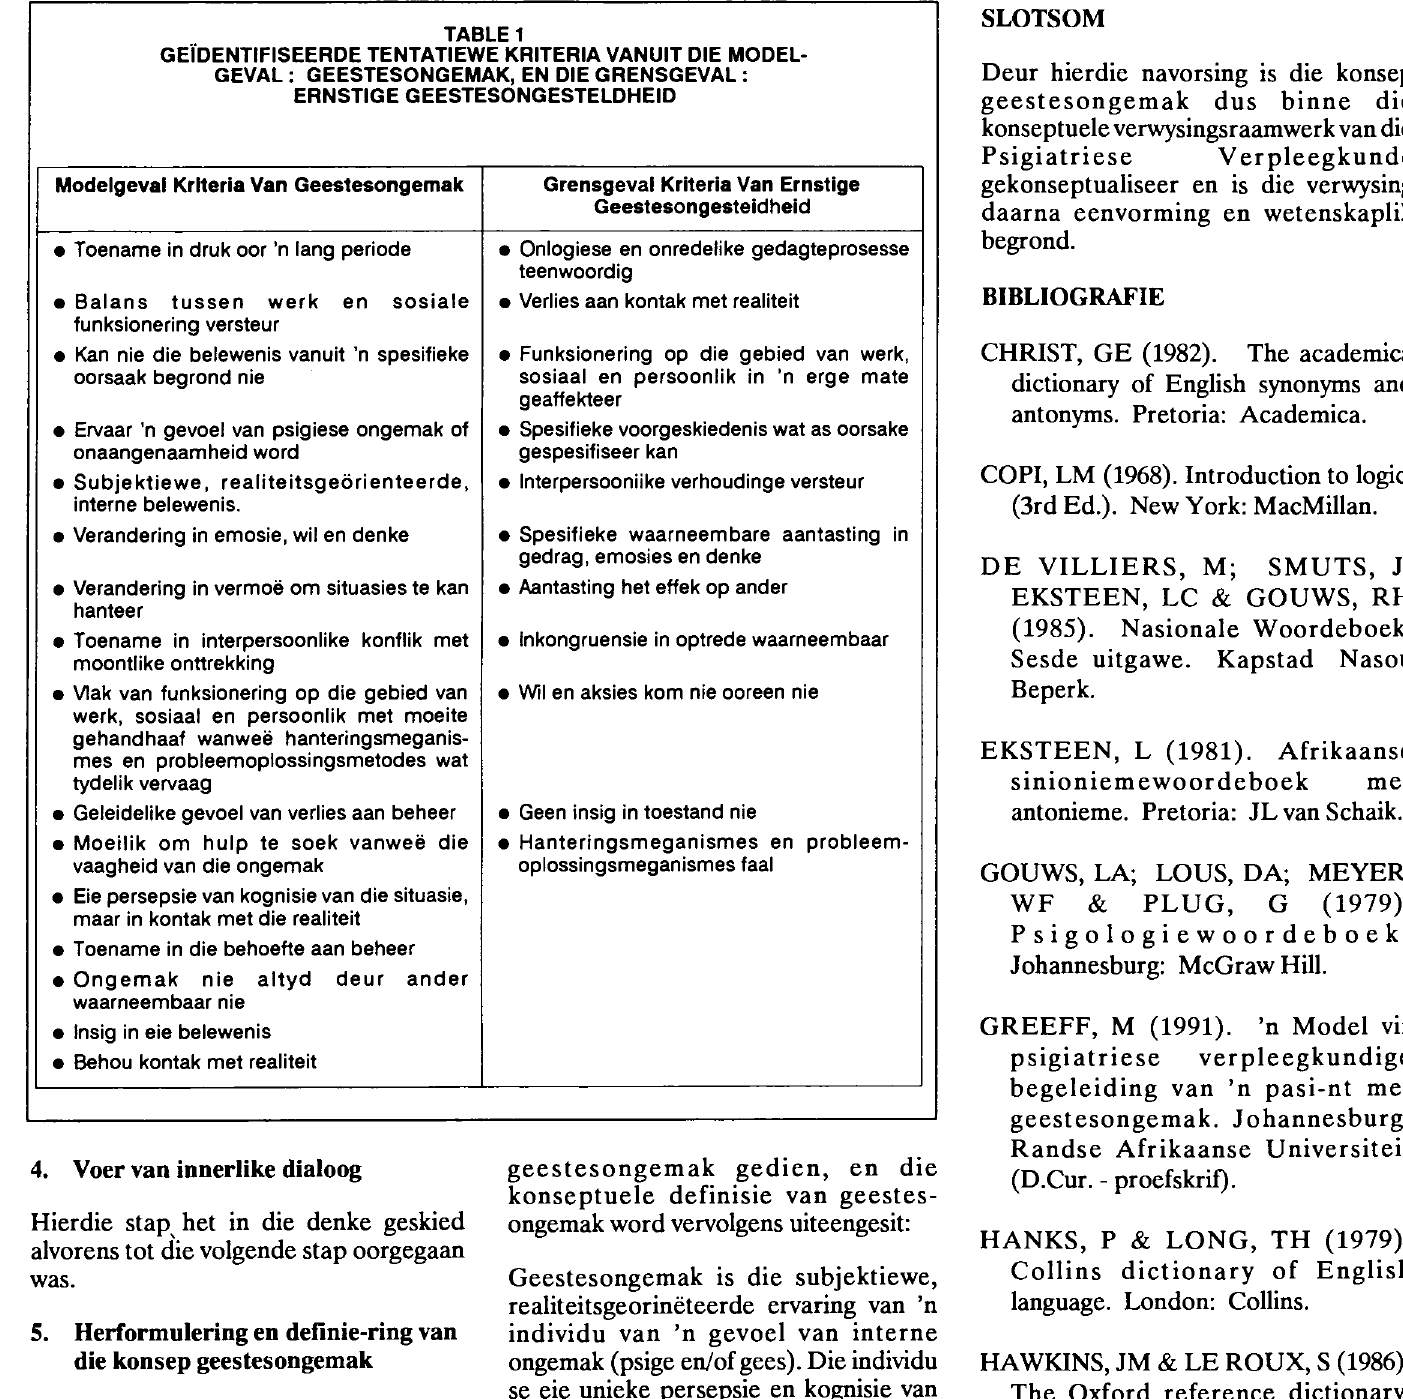
TABLE 1 GEIDENTIFISEERDE TENTATIEWE KRITERIA VANUIT DIE MODEL- GEVAL : GEESTESONGEMAK, EN DIE GRENSGEVAL : ERNSTIGE GEESTESONGESTELDHEID